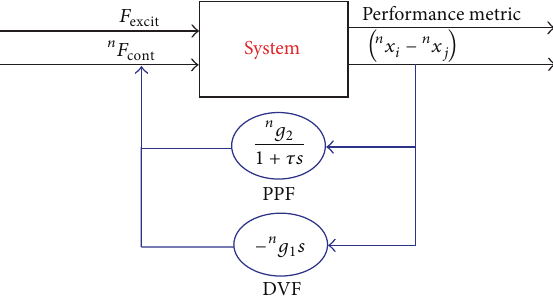
Figure 3: Block diagram of the proposed control